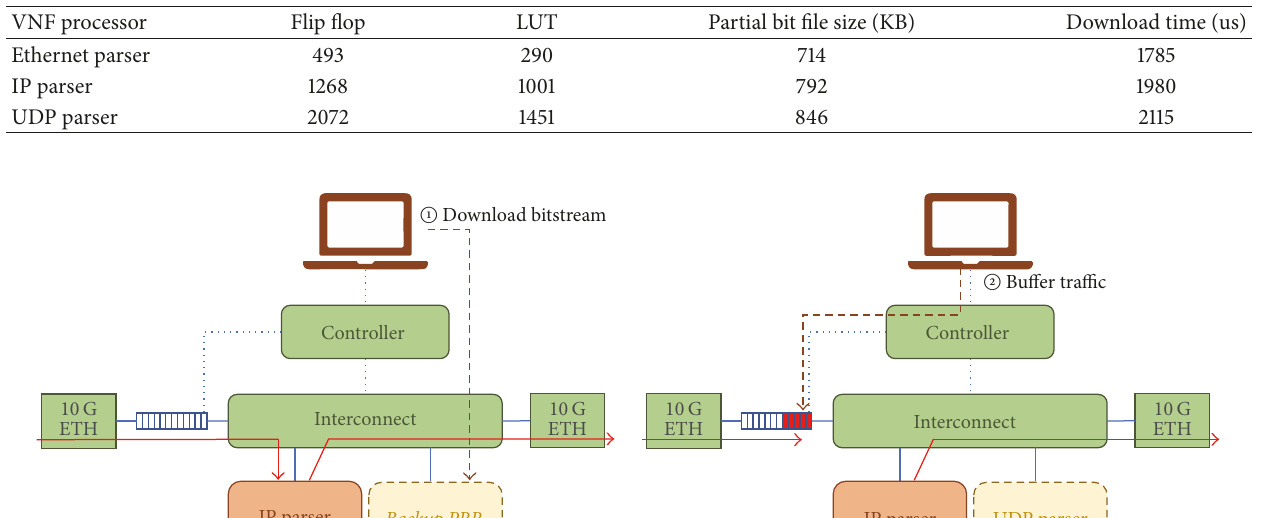
Table 1: Resource utilization and partial bit file size.